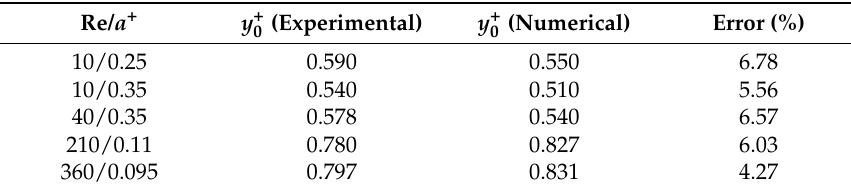
Table 1. Validation of the focusing